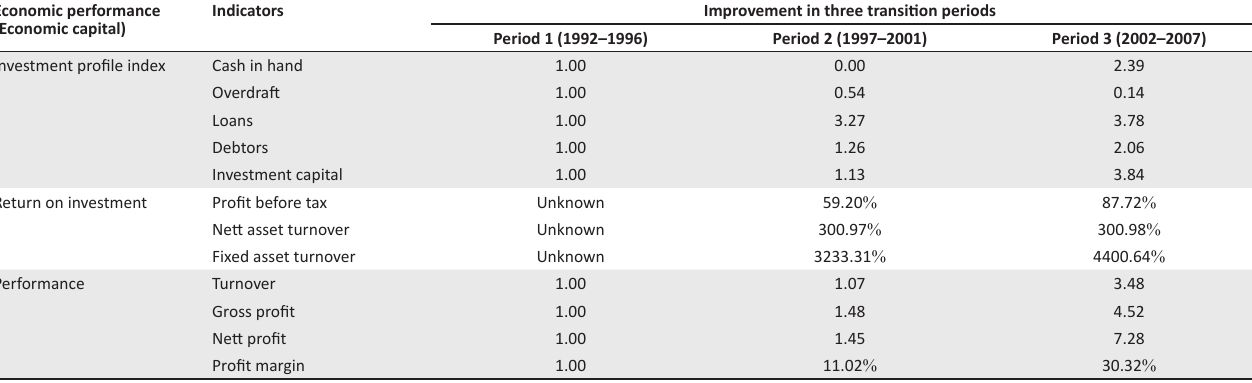
TABLE 2a: Critical capital improvements over lifespan.